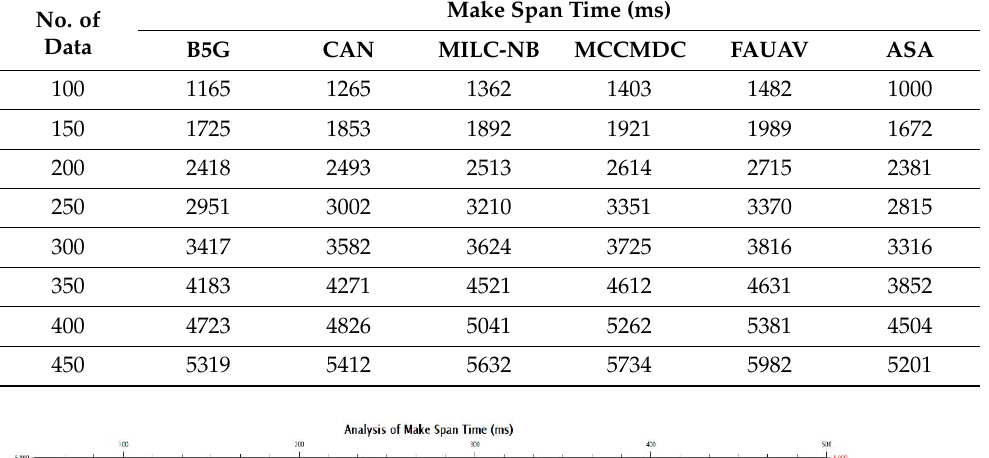
Figure 8. The improvement of Data classification improvement percentage for the ASA compared to other methods. Table 4. Analysis of Make Span Time (ms).